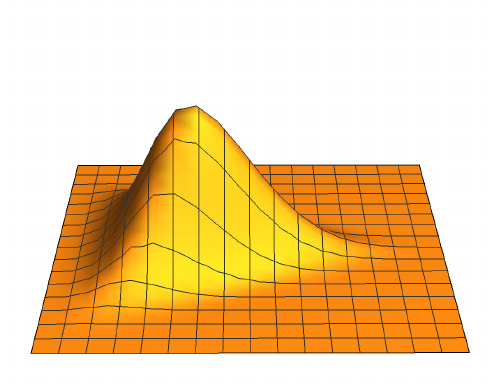
Figure 7. B-spline relative to a